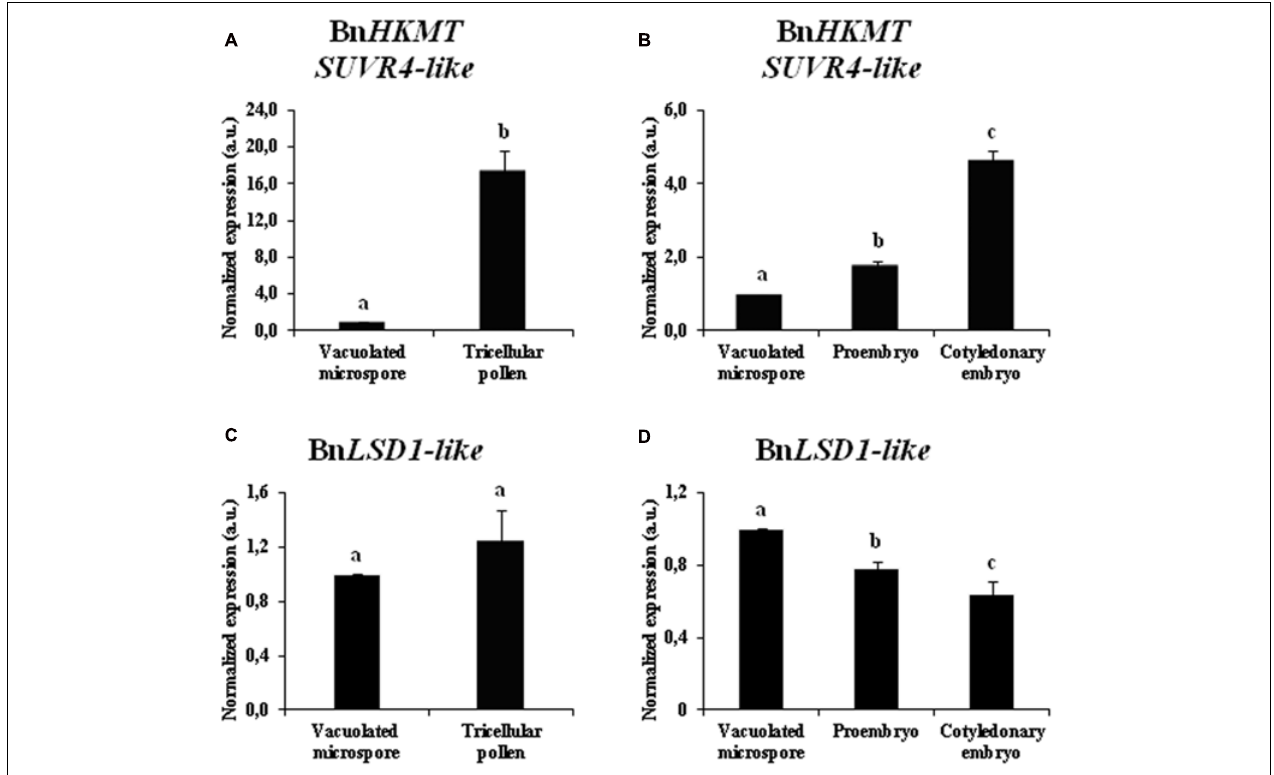
FIGURE 7 | Gene expression patterns of BnHKMT SUVR4-like histone methyltransferase and BnLSD1-like demethylase during pollen development and microspore embryogenesis of Brassica napus , by quantitative qPCR. Histograms express relative changes of expression at different stages of gametophytic development (A,C) and microspore embryogenesis (B,D) : vacuolated microspore (starting point of the two pathways, before reprogramming), tricellular pollen (gametophytic pathway), proembryo and cotyledonary embryo (embryogenic pathway). Transcript levels were normalized to vacuolated microspore levels. Bars indicate the SEM. Different letters on columns indicate significant differences according to ANOVA and Tukey’s tests at p <